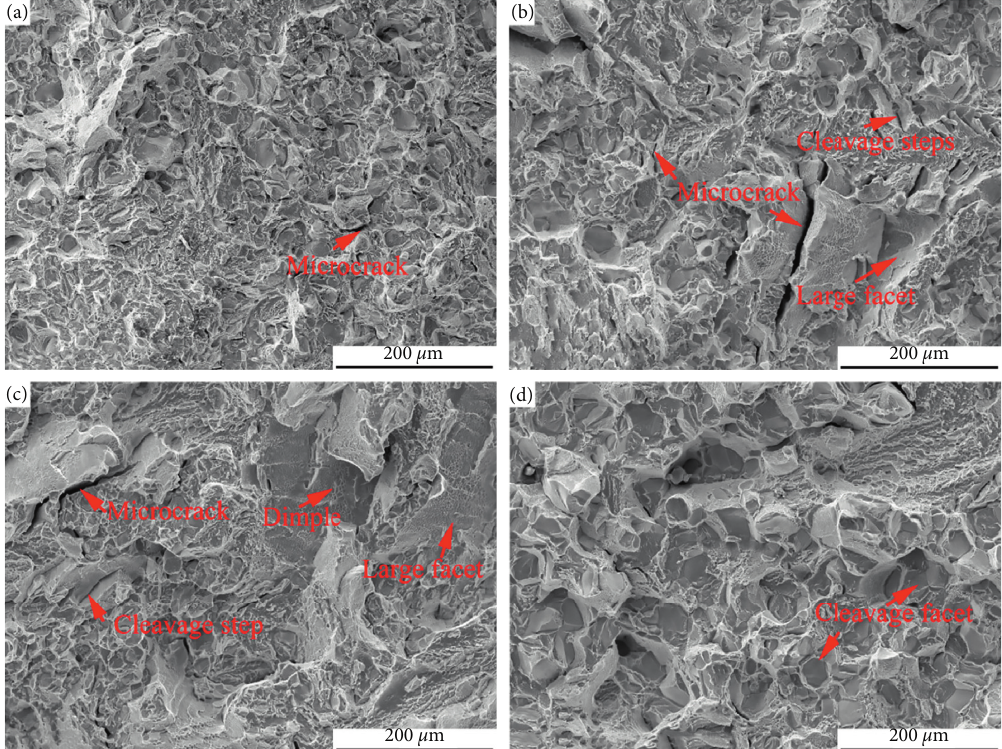
Figure 16: The centre regions of specimens with (a) 9.42% NR percentage, (b) 37.36% NR percentage, and (c) 50.75% NR percentage after rapidly heating to 875 ° C and directly ageing at 500 ° C for 8 hours; (d) centre region of specimen with 34.62% NR percentage after rapidly heating to 950 ° C and directly ageing at 500 ° C for 8